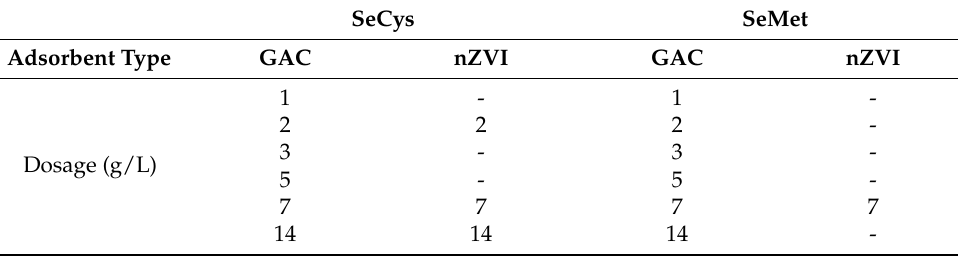
Table 1. Summary of experimental conditions for adsorbent